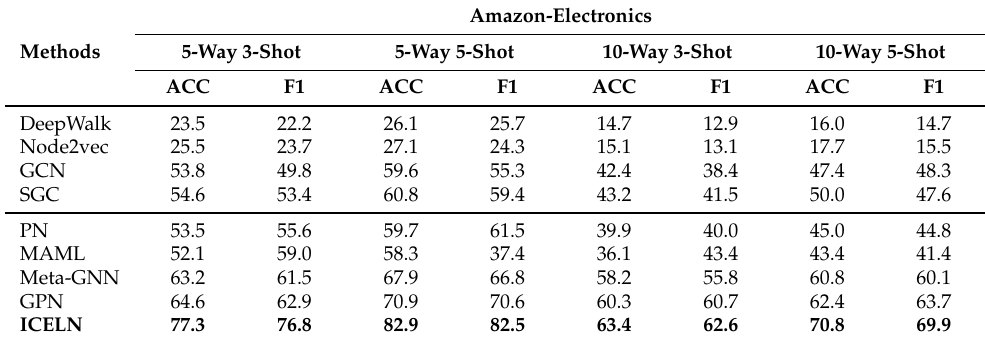
Table 5. The few-shot node classification ACC and F1 score results on